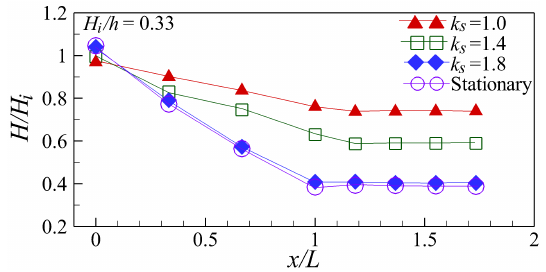
Figure 4. Comparison between the numerical results using the field length of 0.545m and H i = 0.05m.